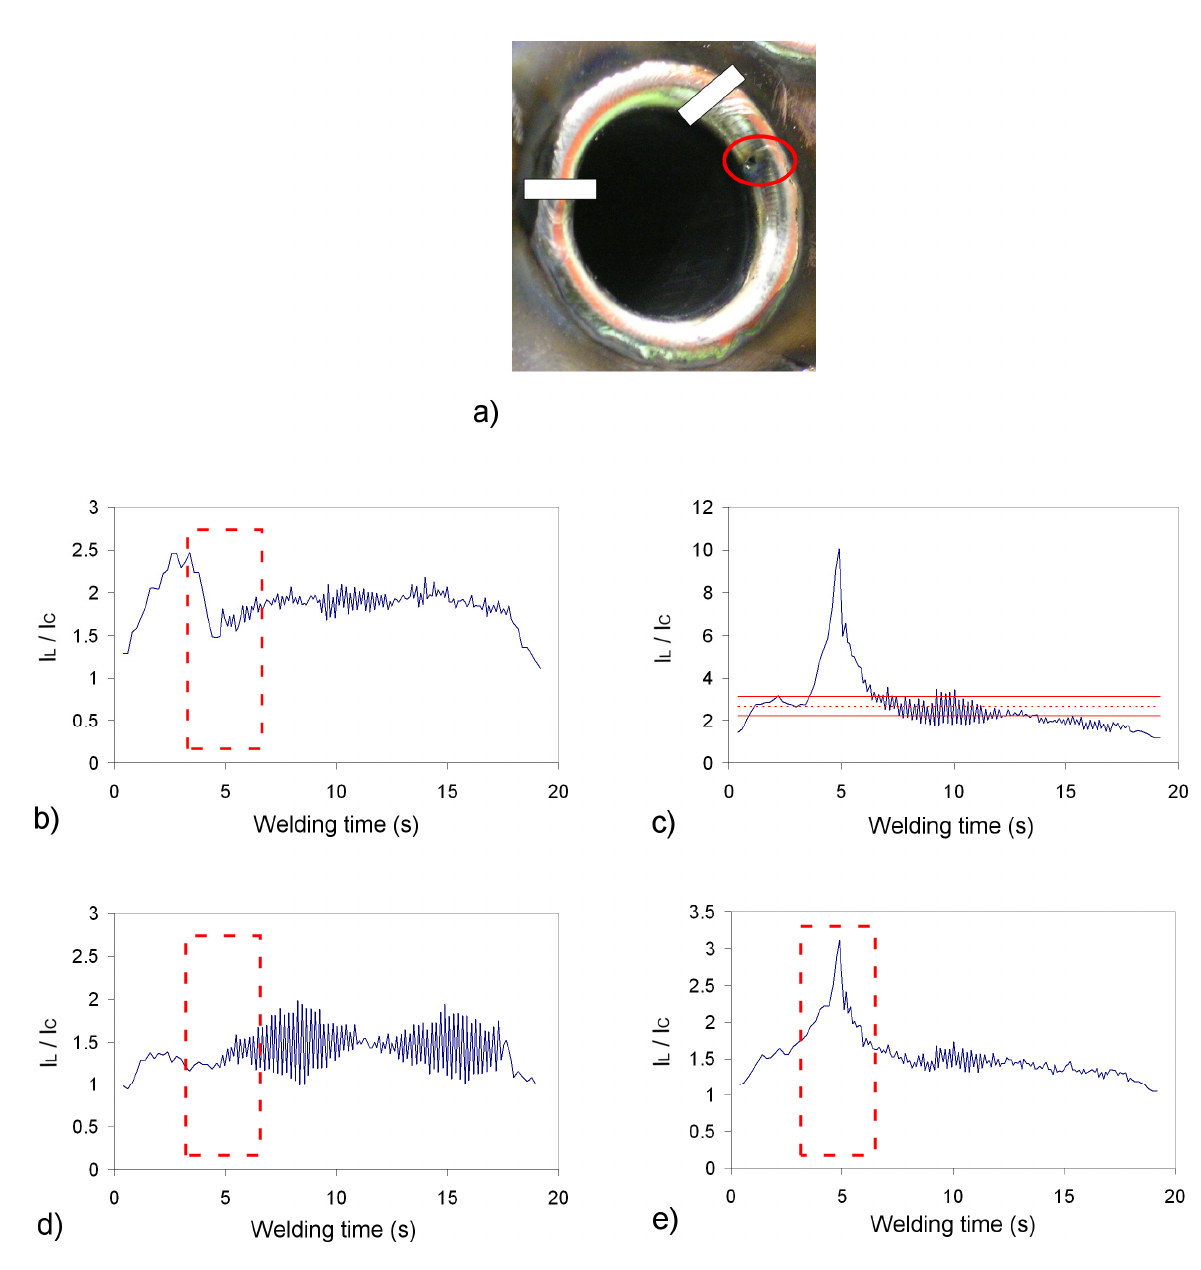
Figure 8. Field test tube with porosity: a) welded tube; b) profile for spectral band 404.14 nm; c) profile for spectral band 422.84 nm; d) profile for spectral band 480.52 nm; e) profile for spectral band 423.64